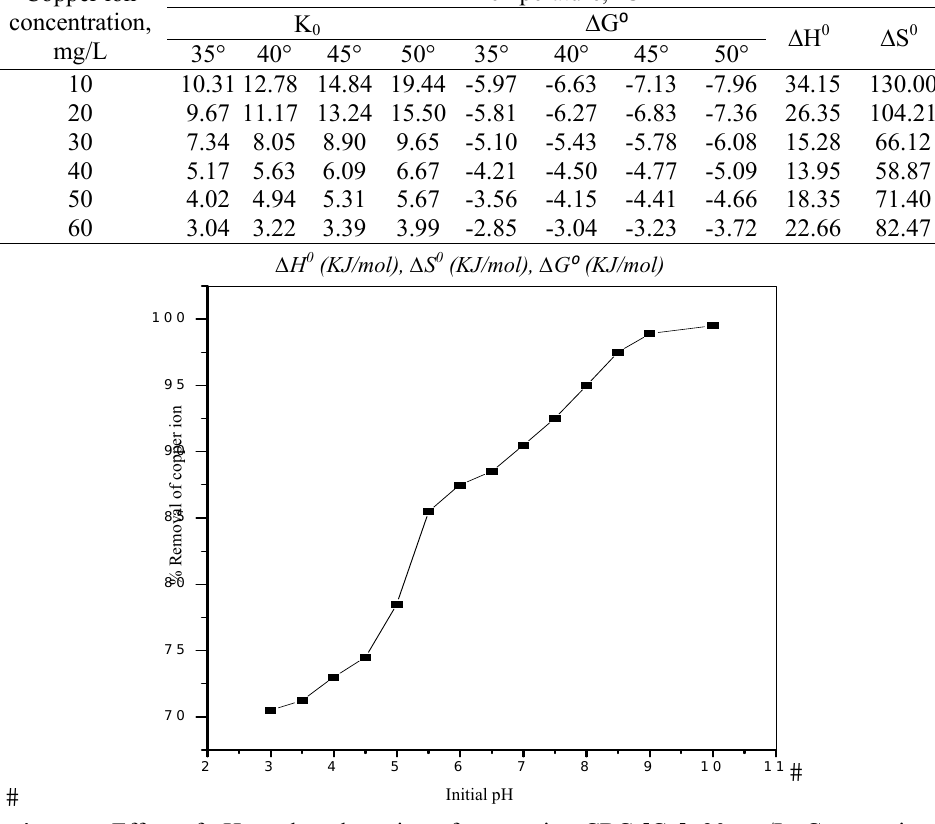
Temperature, ⁰ C ∆ G ⁰ K 0